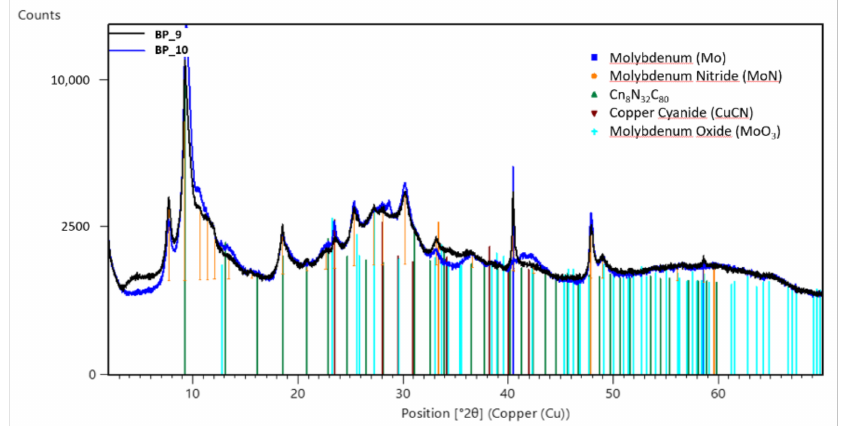
Figure 5. XRD analyses of samples BP_9 and BP_10.